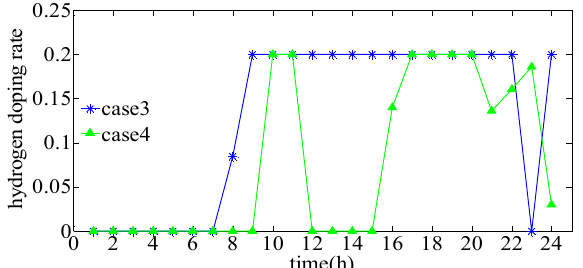
Figure 9. Comparison of hydrogen mixing rate between Case 3 and Case 4. In the figure, the blue curve drawn by asterisk connection represents the hydrogen mixing rate of Case 3; the green curve drawn by triangle connection represents the hydrogen mixing rate of Case 4.